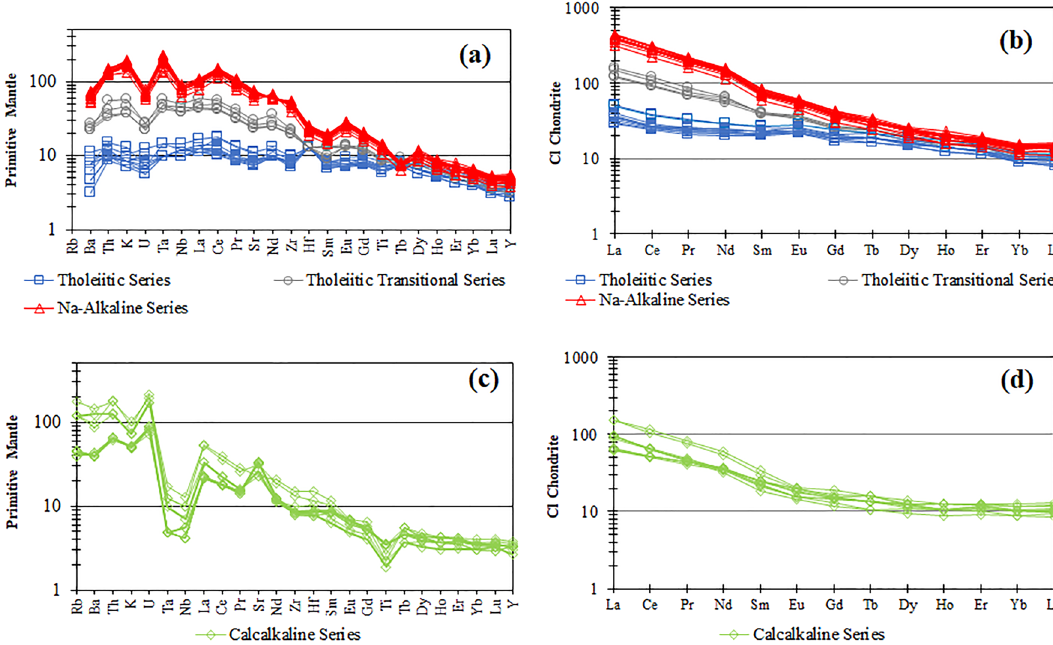
Figure 3. Incompatible trace elements patterns normalized to Primitive Mantle ( a , c ) and Rare Earth Elements patterns normalized to CI Chondrites ( b , d ) according to Sun & McDonough 28 . The millstones belonging to the different magmatic series are reported in Tables S1 and S2. The two rhyodacite ignimbrite samples (Calcalkaline Series) and the phonolite (High-K Alkaline Series) are not reported in these Mugearites (Na‑Alkaline Series). They are represented by 23 porphyritic lava millstones (Table S2; Figs. 2, 3a,b) with a Porphyritic Index (PI) between 15 and 30 vol% and an intergranular to pilotassitic microcrys- talline groundmass (Fig. S2a,b). Mostly rounded vescicles may reach 10–15 vol%. Modal mineralogy, both as phenocrysts and groundmass, is mainly constituted by plagioclase and clinopyroxene. Olivine is also present as a fundamental mineral whereas opaques represent the main accessory phases. Secondary calcite crystals may occur. Basalts (Tholeiitic Transitional Series). The two basalts (Table S2; Figs. 2a,b, 3a,b) show different textures. MH104 is a doleritic sub-aphyric lava with a PI ≤ 1 vol% and a vesiculation of 5–7 vol% with some secondary phases (mainly calcite) filling the vesicles. The rare phenocrysts and the groundmass are represented by oxi- dized olivine, plagioclase, clinopyroxene and opaques minerals consisting of rounded grains of magnetite and laths of ilmenite. Fine-grained clinopyroxenite cumulates/xenocrysts are also detected. By contrast MH53 basalt (Fig. S2c) is a porphyritic lava (PI 5–7 vol%) with a microcrystalline intergranular groundmass and a vesicula- tion of about 3–5 vol%. The fundamental mineral assemblage is constituted by olivine, plagioclase and clinopy- roxene whereas opaque rounded grains are the accessory phases. Basaltic andesites (Tholeiitic, Tholeiitic Transitional and Calcalkaline Series). They can be distinguished by chemical composition (Table S2; Fig. 3). As concerning the thin section petrography, the tholeiitic basaltic andesites (14 samples) are represented by doleritic microcrystalline nearly aphyric lavas, with an intergranu- lar groundmass. A relatively high vesicularity (10–25 vol%), at places containing secondary calcite crystals is very common. The modal mineralogy consists of plagioclase laths, pale green clinopyroxene, more or less oxi- dized olivine and sub-rounded grains and laths of opaque minerals (magnetite and ilmenite) as accessory phases (Fig. S2d,e). The two Tholeiitic Transitional basaltic andesites (Fig. S2f) are constituted by a microcrystalline intergranular groundmass with a PI of about 5 vol% and vesiculation of 3–5 vol%. The mineralogical assemblage is represented by plagioclase, clinopyroxene, skeletal oxidized olivine and opaques minerals as rounded grains or laths. As described for the doleritic basalt (MH104), also in these samples fine-grained clinopyroxenite cumu- lates/xenocrysts are present. The five basaltic andesites of the Calcalkaline Series (Fig. S2g) are represented by porphyric-seriate lavas (PI 15–20 vol%) with a microcrystalline groundmass, at places intergranular to pilotas- sitic and vesicles around 5 vol%. The phenocrysts consist of well-developed plagioclases with, at places, concen- tric zonation, and pale green clinopyroxene with inclusions of opaque minerals. The same mineral assemblage constitutes the groundmass where opaques are also present. Their K 2 O/Na 2 O ratios are between 0.48 and 0.51 (Table S2). Andesites (Calcalkaline Series). These eight samples (Table S2; Fig. 3c,d) are represented by highly porphyritic lavas (PI 25–35 vol%) with micro-cryptocrystalline to glassy groundmass (Fig. S2h). The vesiculation is rela-